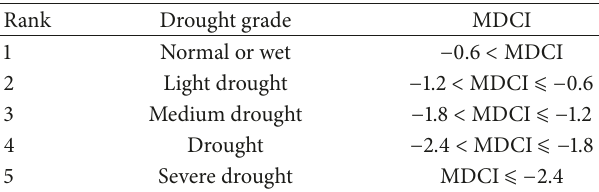
Table 1: Drought rank of